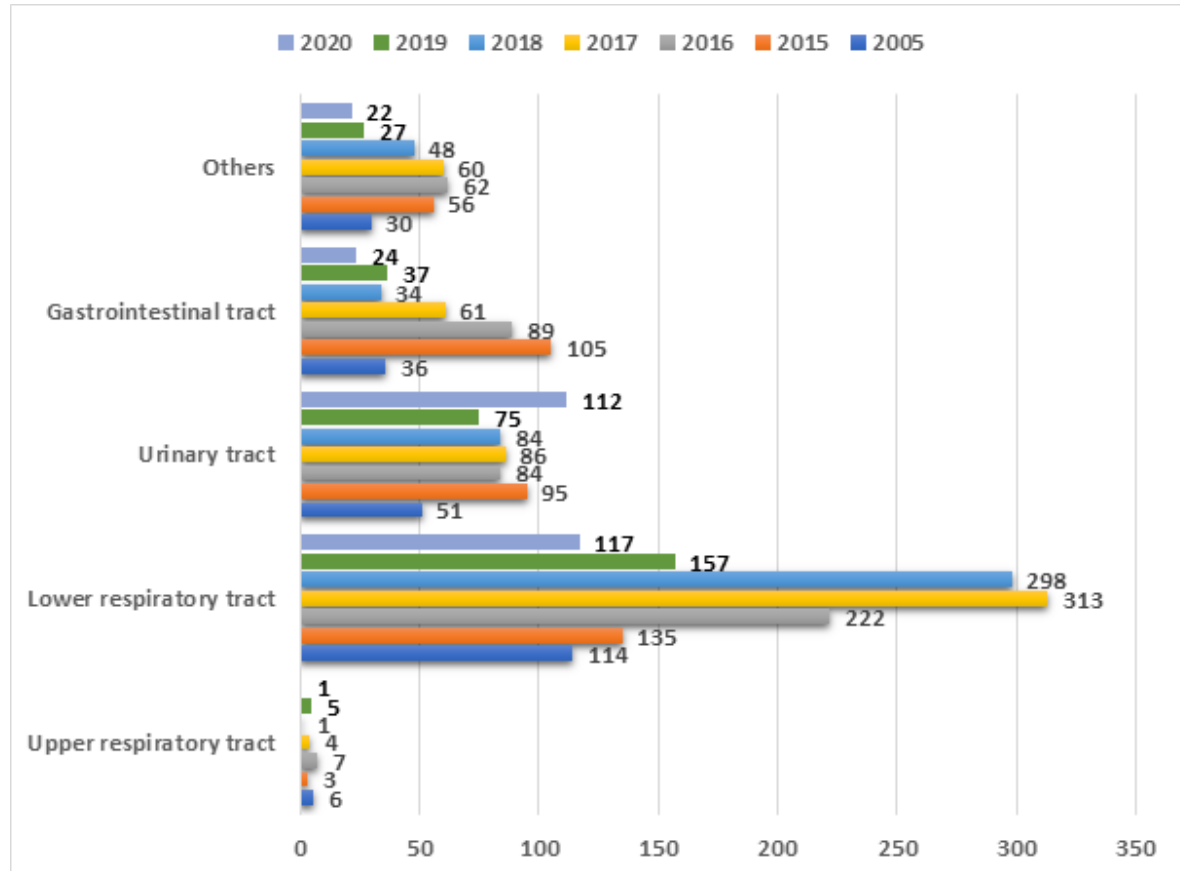
Figure 1. Number of samples from PCICU divided into 5 source groups. The distribution of the results collected from PCICU in the studied years, including the number of positive tests is shown in Figure 2.